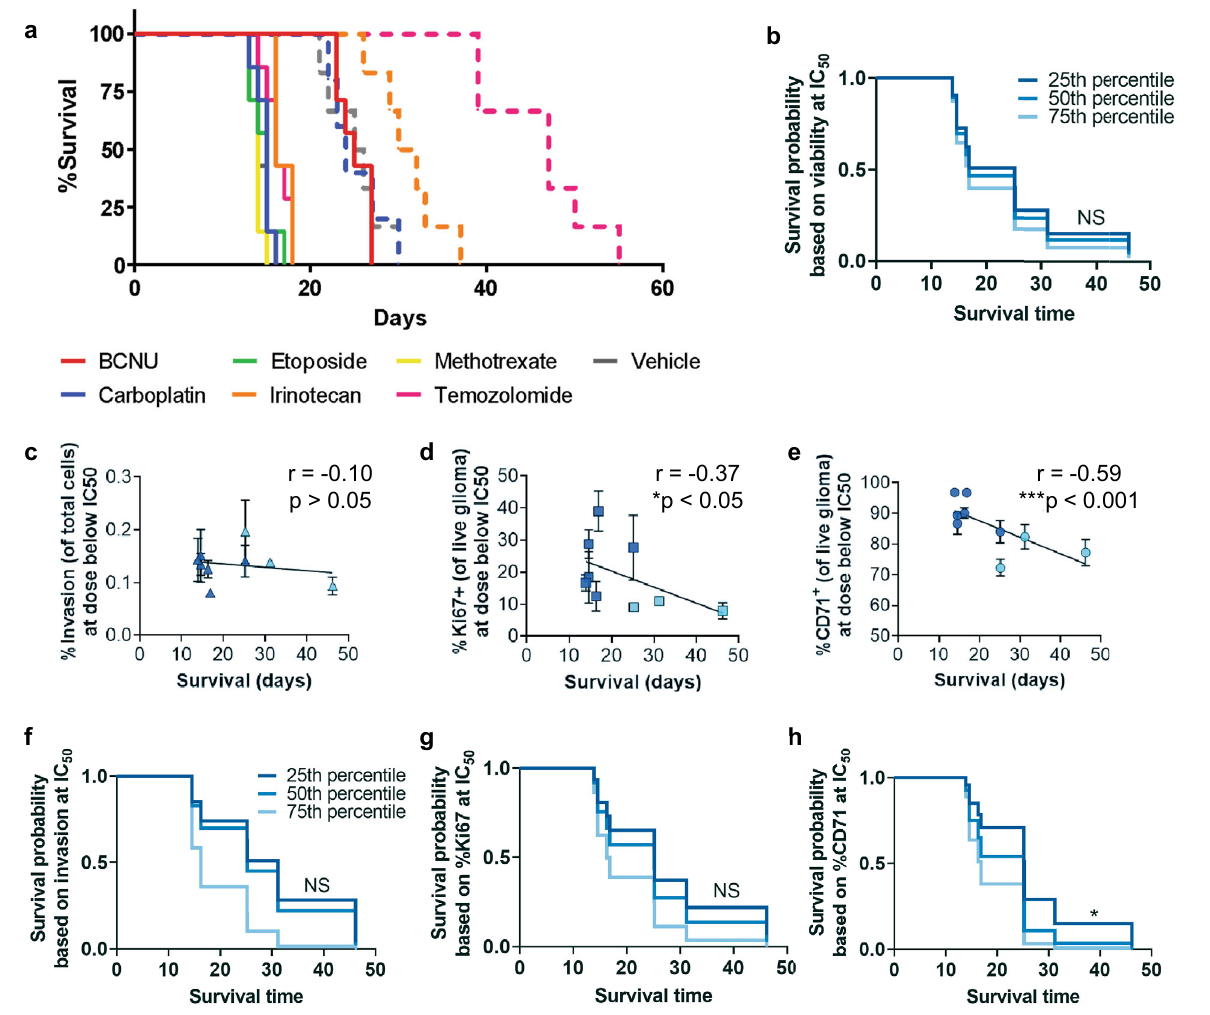
Fig. 6 Metrics for proliferation and stemness correlate with xenograft survival, with in vitro stemness predicting in vivo drug response. a Kaplan – Meier plots for orthotopic xenografts of 10,000 G34 (solid lines) and 400,000 G528 (dashed lines) treated with chemotherapies at concentrations and regimens based on published literature. G528 was only tested with temozolomide, carboplatin, and irinotecan. Statistical comparisons are shown in Supplementary Fig. 10. b Proportional hazards model built using in vivo survival data and in vitro viability data in the TME model at the dose-below-spheroid-IC 50 value. c – e Collective in vitro responses at the dose-below-spheroid-IC 50 value of G34 (dark blue) and G528 (light blue) treated with drugs in the TME model for invasion ( c ), proliferation ( d ), and stemness ( e ). Each data point is n = 4, with 6 drug responses for G34 and 3 drug responses for G528. Pearson correlation coef fi cients and p values are shown on respective plots ( N = 9). f – h Proportional hazards models built using in vivo survival data and data from ( c – e ), examining the ability to predict xenograft survival given the percent invasion ( f ), proliferation ( g ), and stemness ( h ). Only stemness was able to predict in vivo therapeutic response (by proportional hazards model with * p < 0.05). NS indicates not signi fi